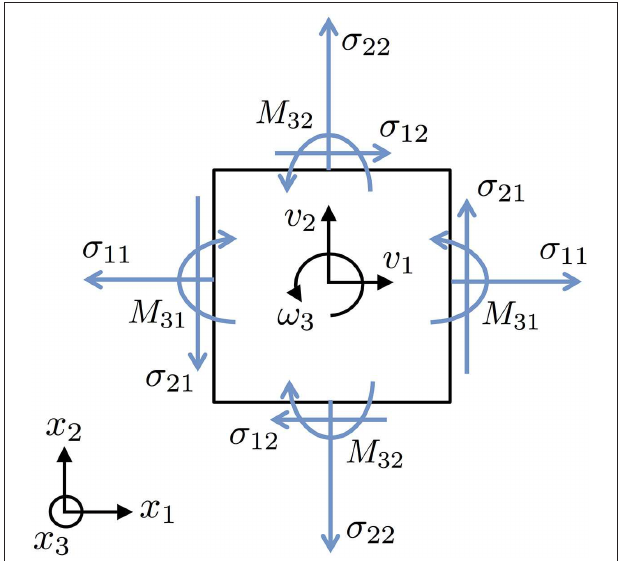
FIGURE 1 | Primary fields in a Cosserat continuum (in-plane components shown). Note that σ 21 may differ from σ 12 , ω may differ from couple stress tensor components M ij admit surface moment down to the continuum scale.